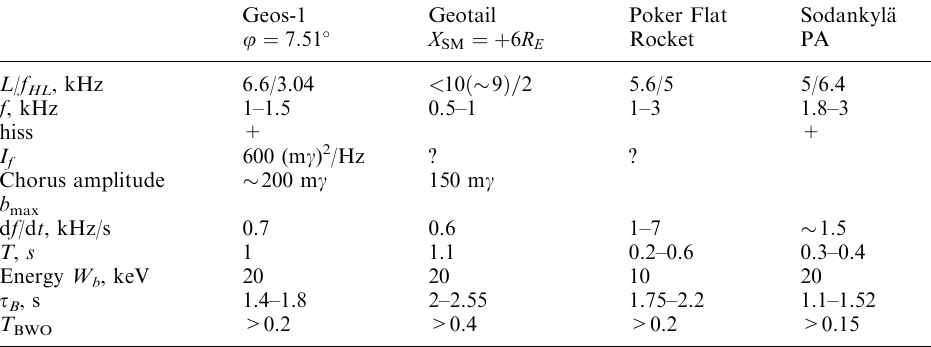
Table 1. Parameters of chorus, taken from satellite and ground- based